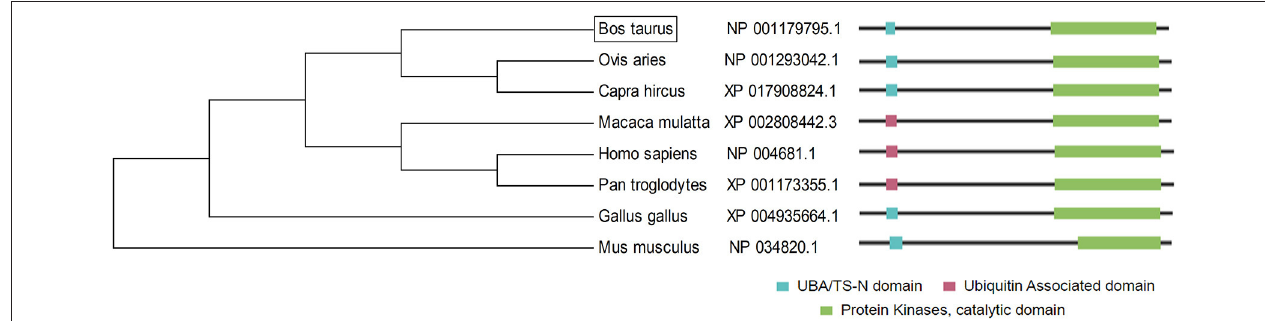
FIGURE 3 | The construction of LATS 1 protein phylogenetic tree. On the left side, there is the clustering of LATS 1 protein in different species and on the right side, there is the architecture and characteristics of LATS 1 protein amino acid length in corresponding species.